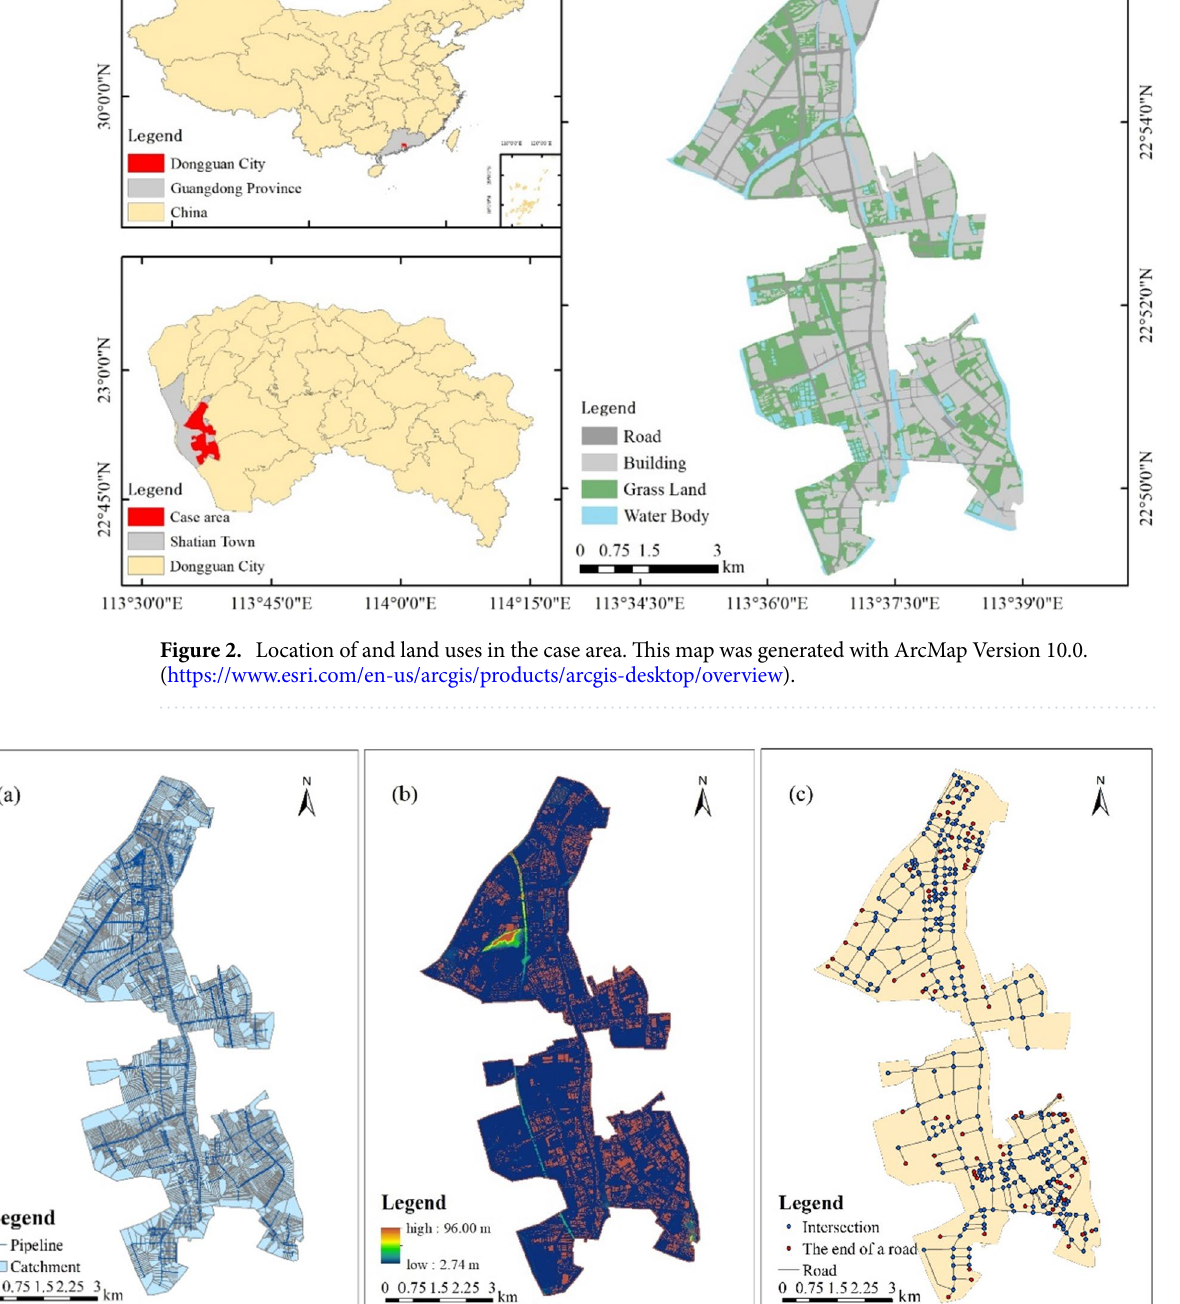
Figure 3. Data for modeling simulation: ( a ) urban drainage network; ( b ) DEM data of case area; ( c ) road network. This map was generated with ArcMap Version 10.0. (https:// www. esri. com/ en- us/ arcgis/ produ cts/ arcgis- deskt op/ overv